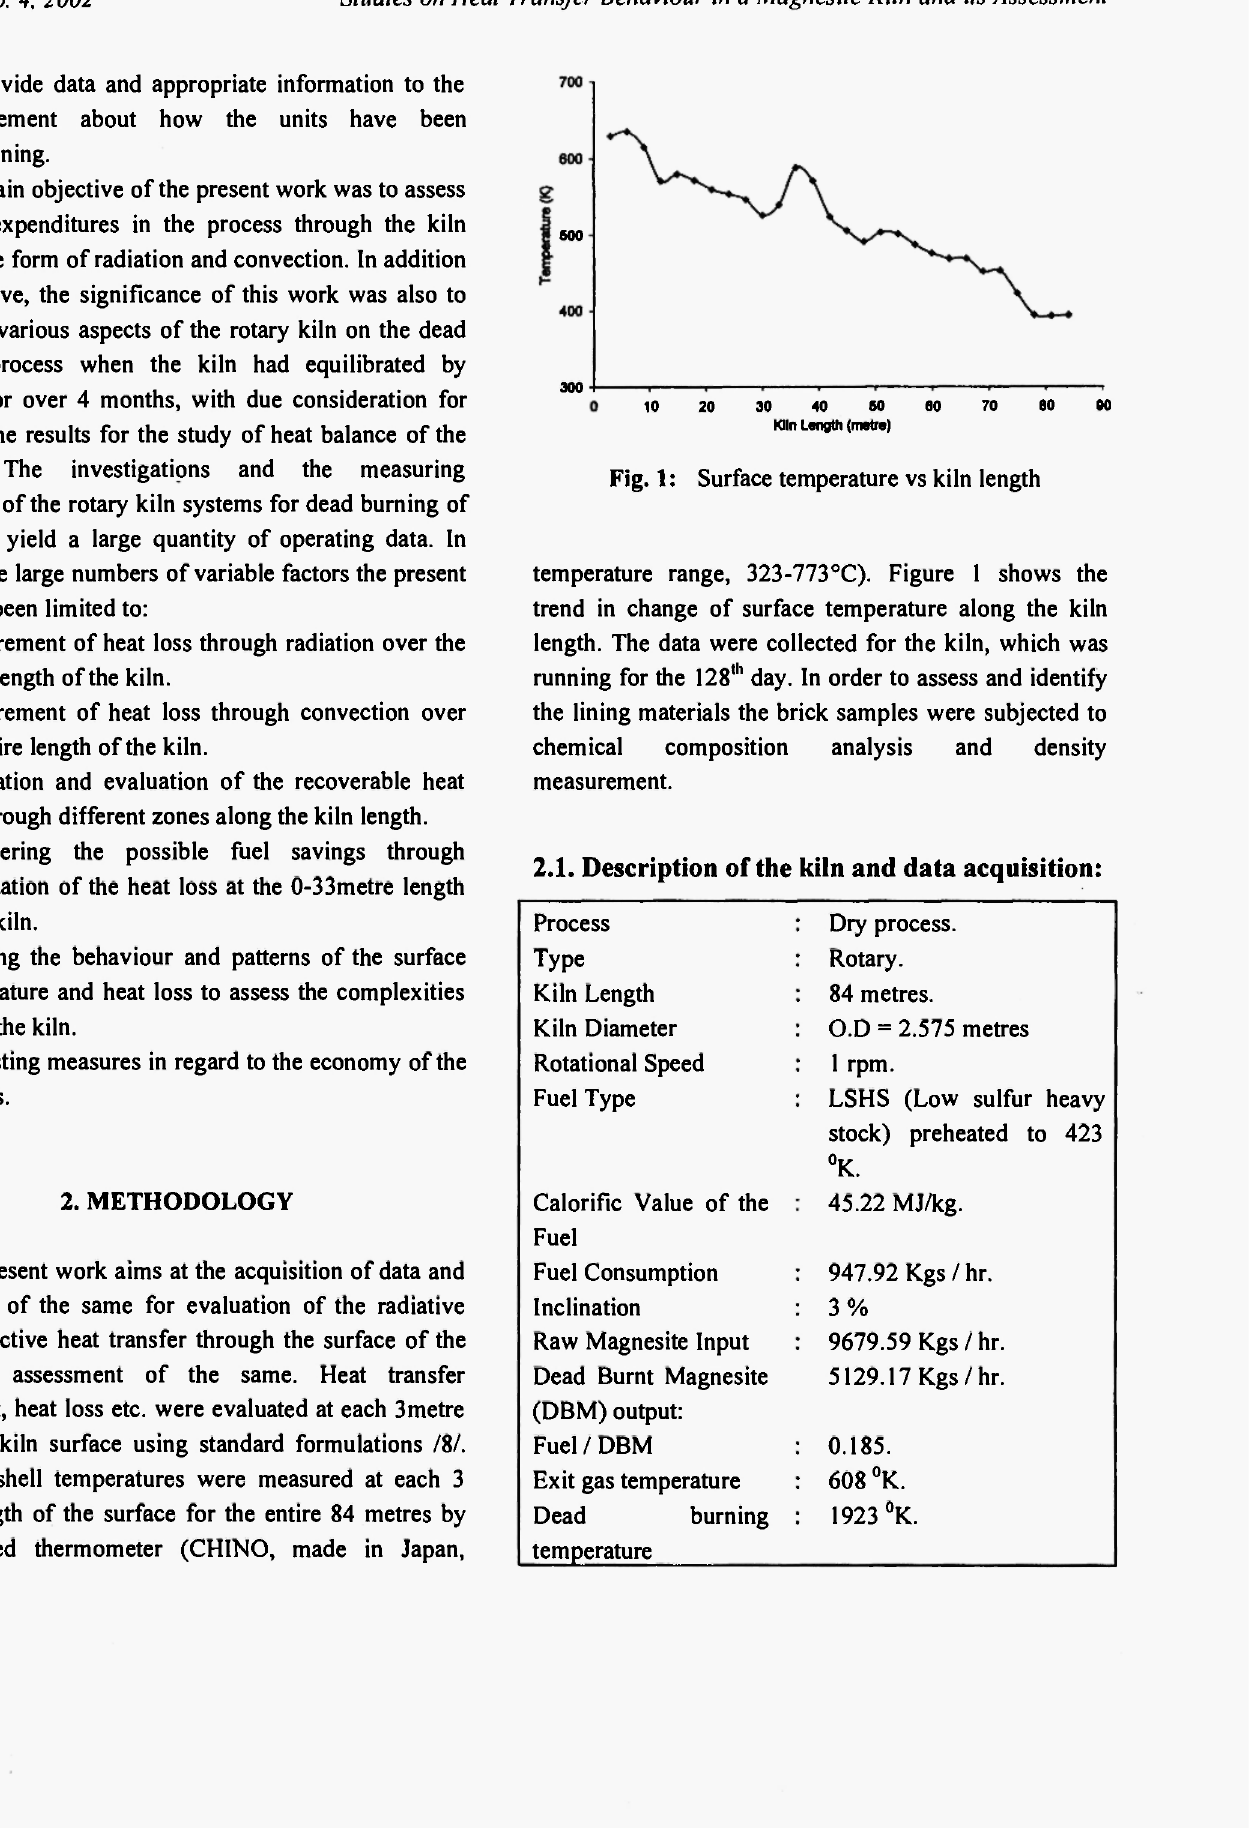
Fig. 1: Surface temperature vs kiln length